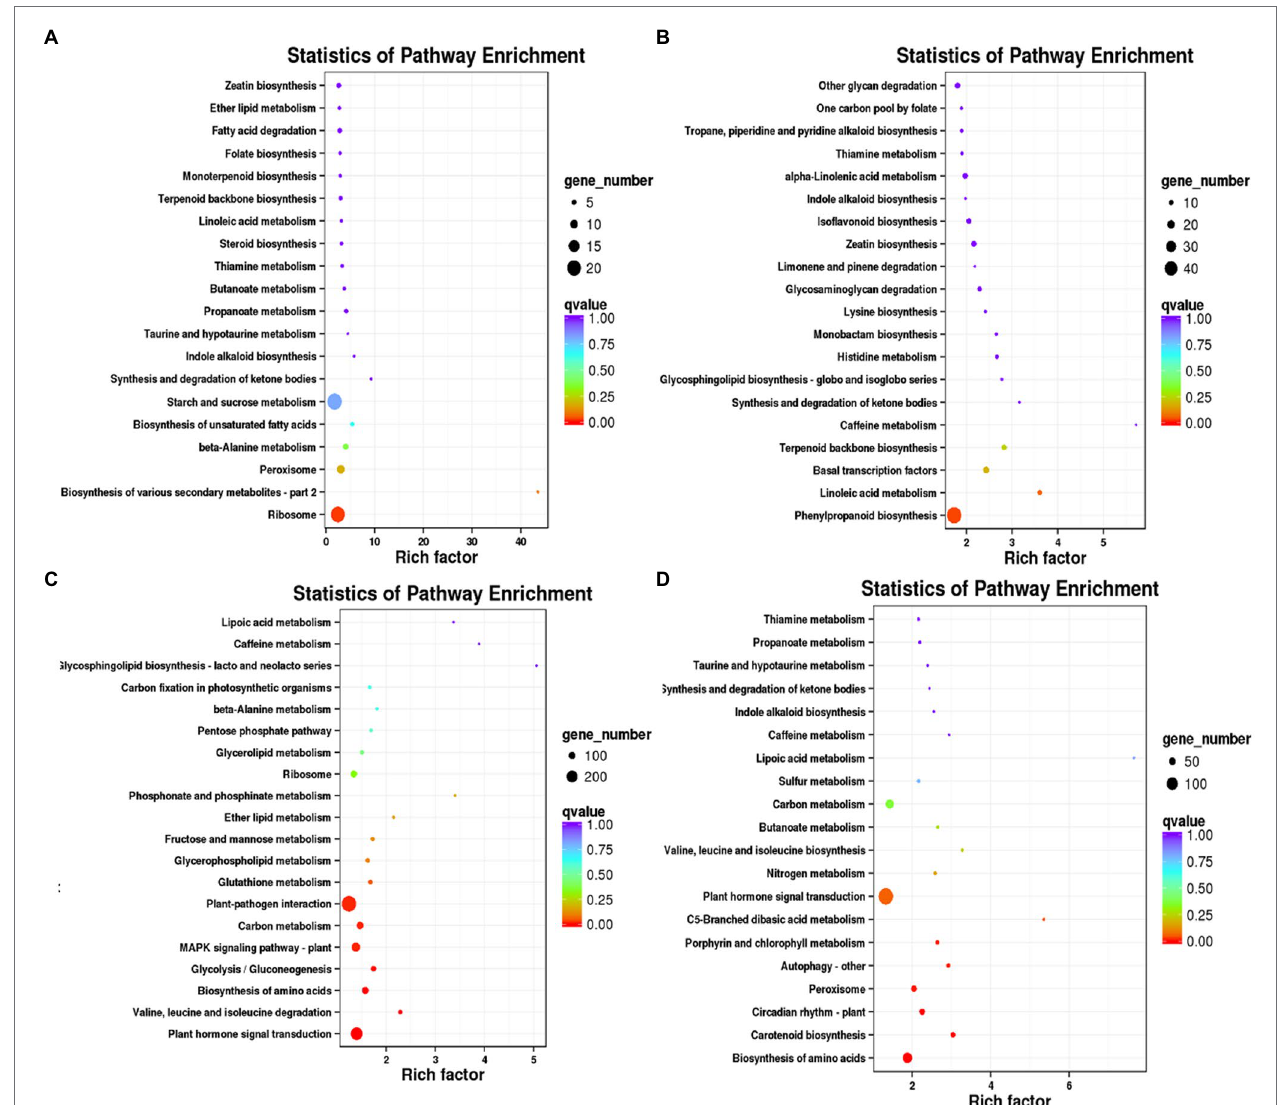
FIGURE 3 | KEGG enrichment analysis of DEGs specific to days 7, 14, 21, and 28 in WL343HQ inoculated with Verticillium alfalfae (WL + V). (A) KEGG enrichment analysis of DEGs specific to days 7. (B) KEGG enrichment analysis of DEGs specific to days 14. (C) KEGG enrichment analysis of DEGs specific to days 21. (D) KEGG enrichment analysis of DEGs specific to days